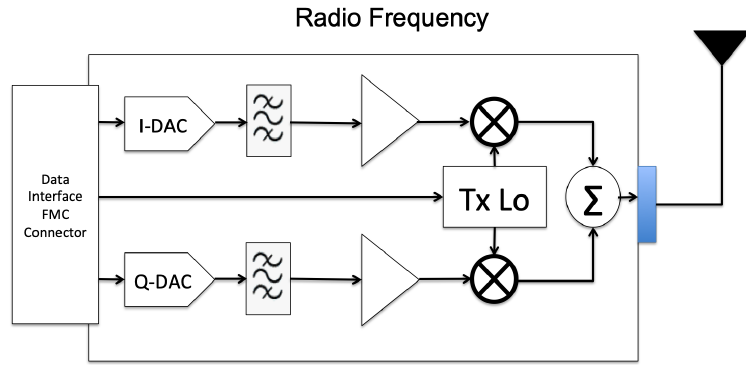
Figure 2. Radio frequency model. RF PCB scheme and AD9364